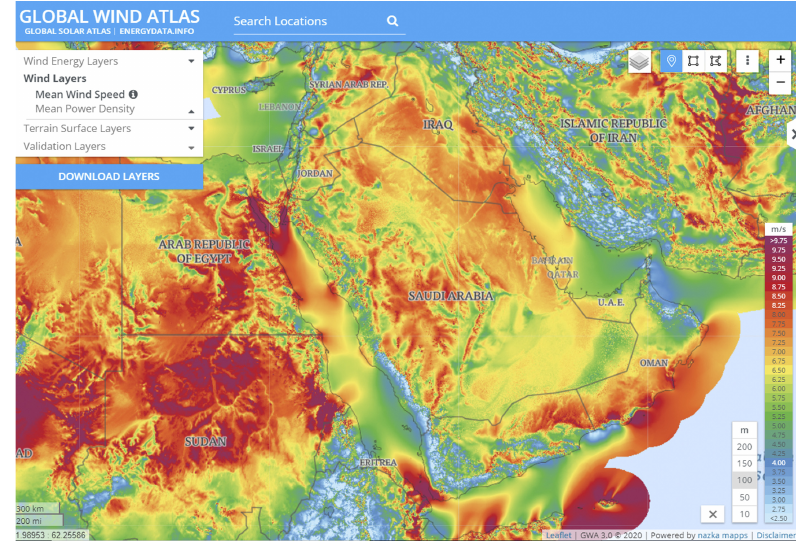
Figure 1. High wind